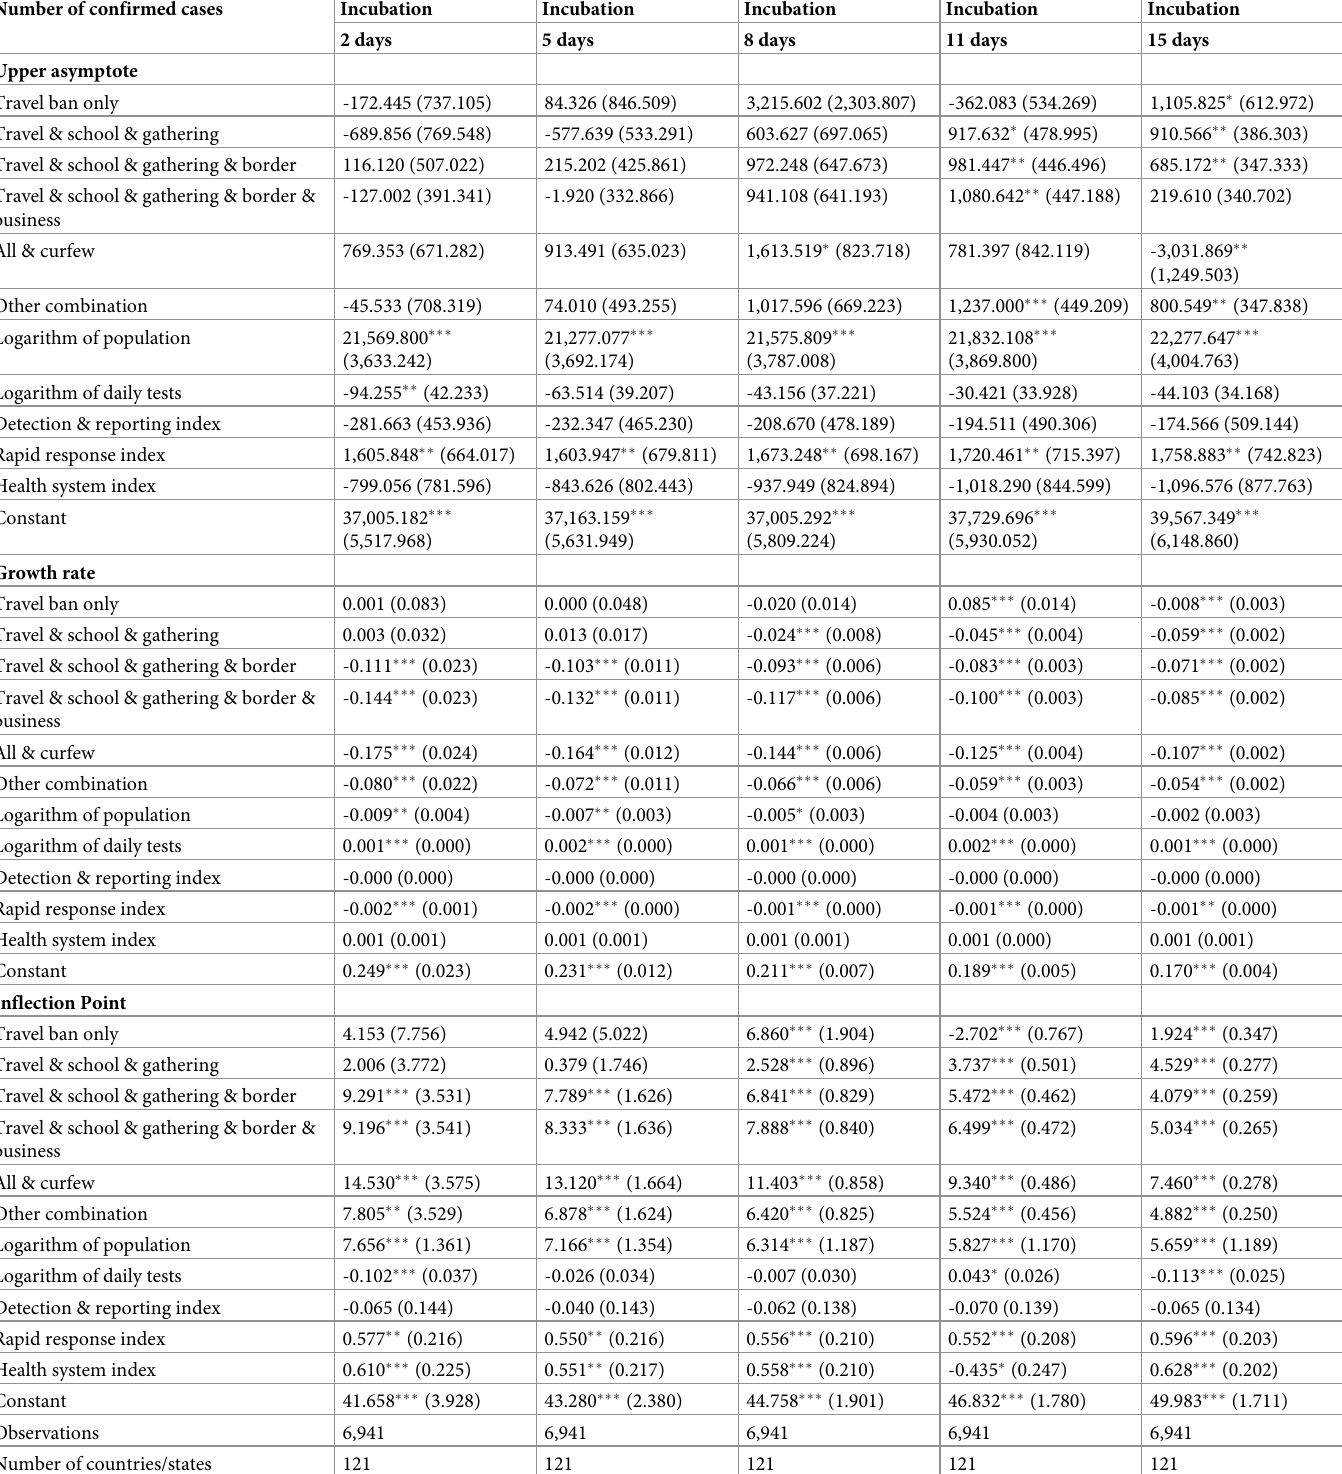
Table 4. Nonlinear mixed-effect regression results of the combinations of individual